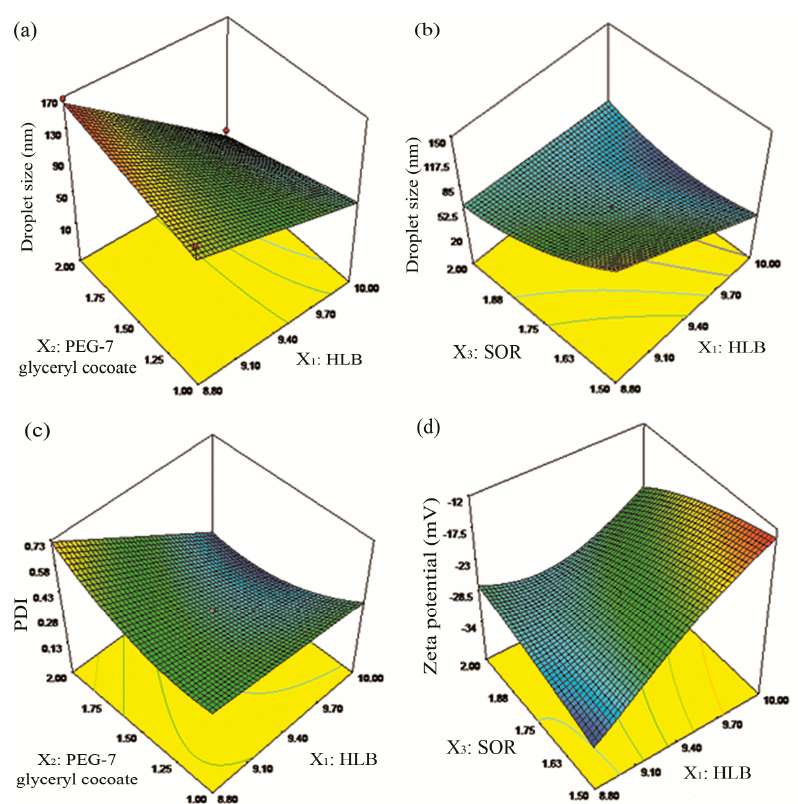
Figure 1. Response surface plots demonstrating the significant ( p < 0 . 05 ) interaction effects on the studied variations including ( a , b ) droplet size ( Y 1 : nm), ( c ) polydispersity index (PDI: Y 2 ), and ( d ) zeta potential ( Y 3 : mV).